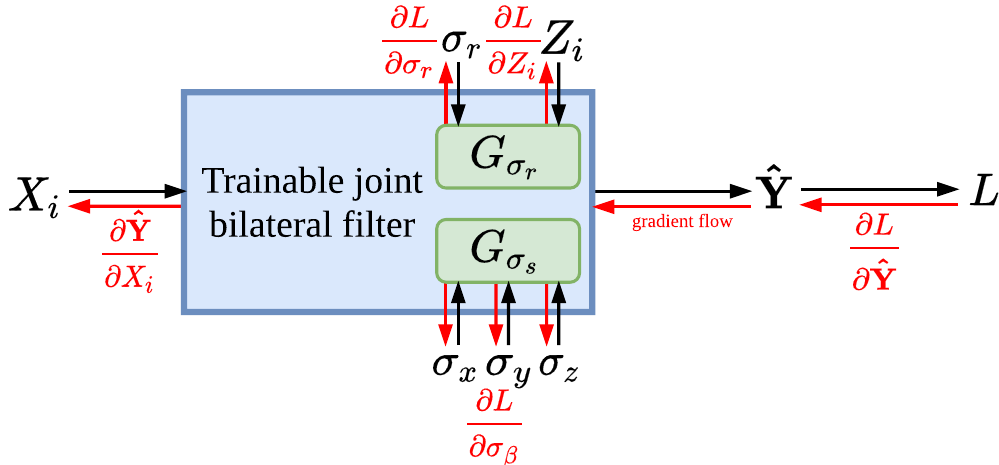
Figure 1. Illustration of the proposed trainable joint bilateral filter layer. In the forward pass (black arrows), the input X i is filtered using parameters σ γ (γ ∈ { x , y , z , r } ) and the guidance image Z i to predict the denoised image ˆ Y . The model’s loss is indicated as L . Analytical derivatives are calculated in the backward pass (red arrows) toward filter input, guide, and